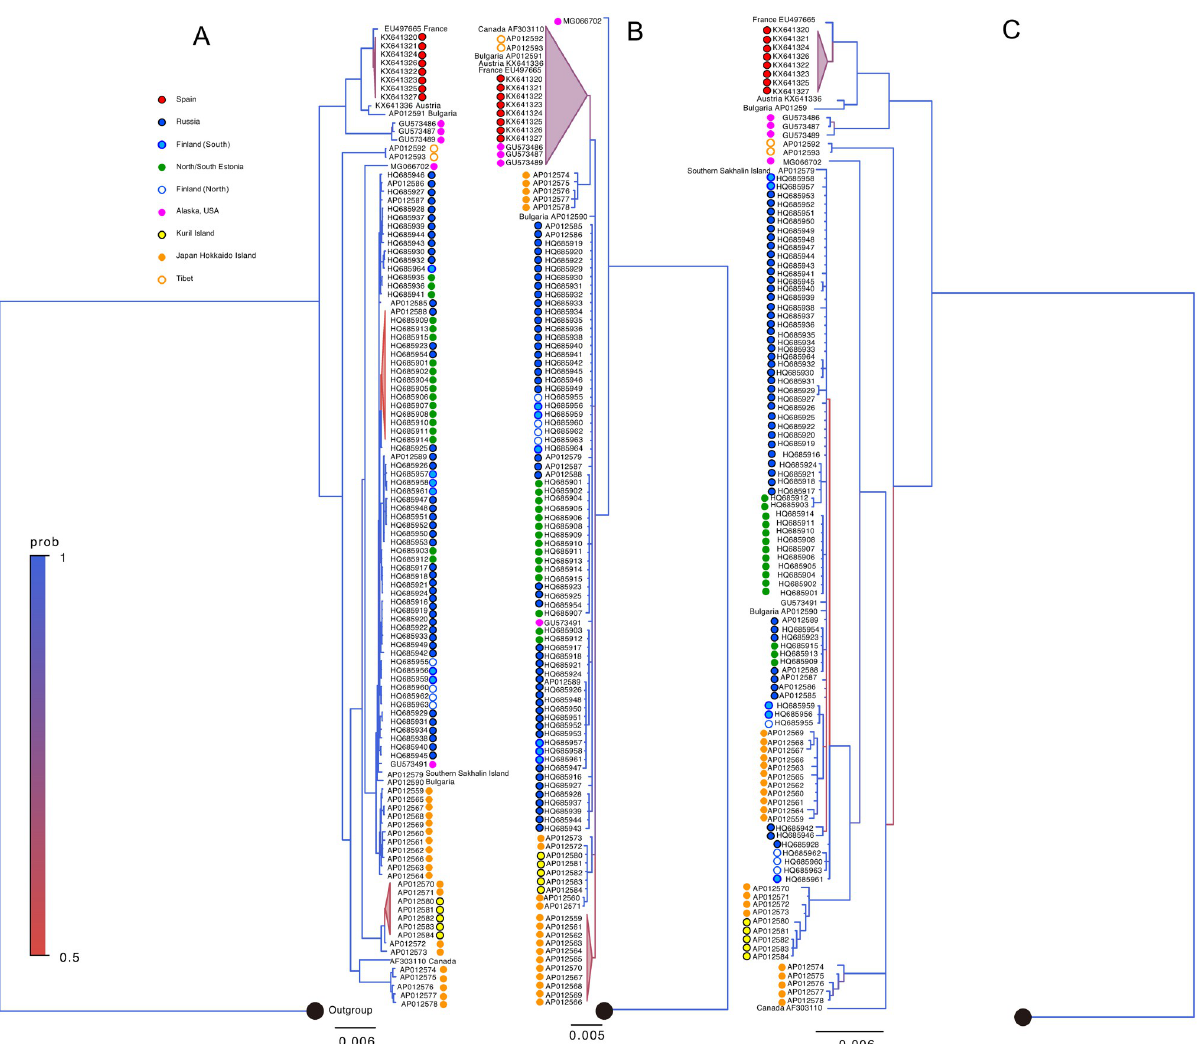
Fig 7. Phylogenetic divergence of (A) full-length mtDNA and (B) cox1, and (C) contiguous sequence including cob to rnS of U . arctos . The phylogenetic trees were reconstructed and rooted with Ursus thibetanus ussuricus as an outgroup (NCBI accession EF681884.1). Branches with a posterior probability of 0.5 to 1.0 are expressed in color as indicated. Each branch is color-coded by the geographic origin of the individuals, as indicated in